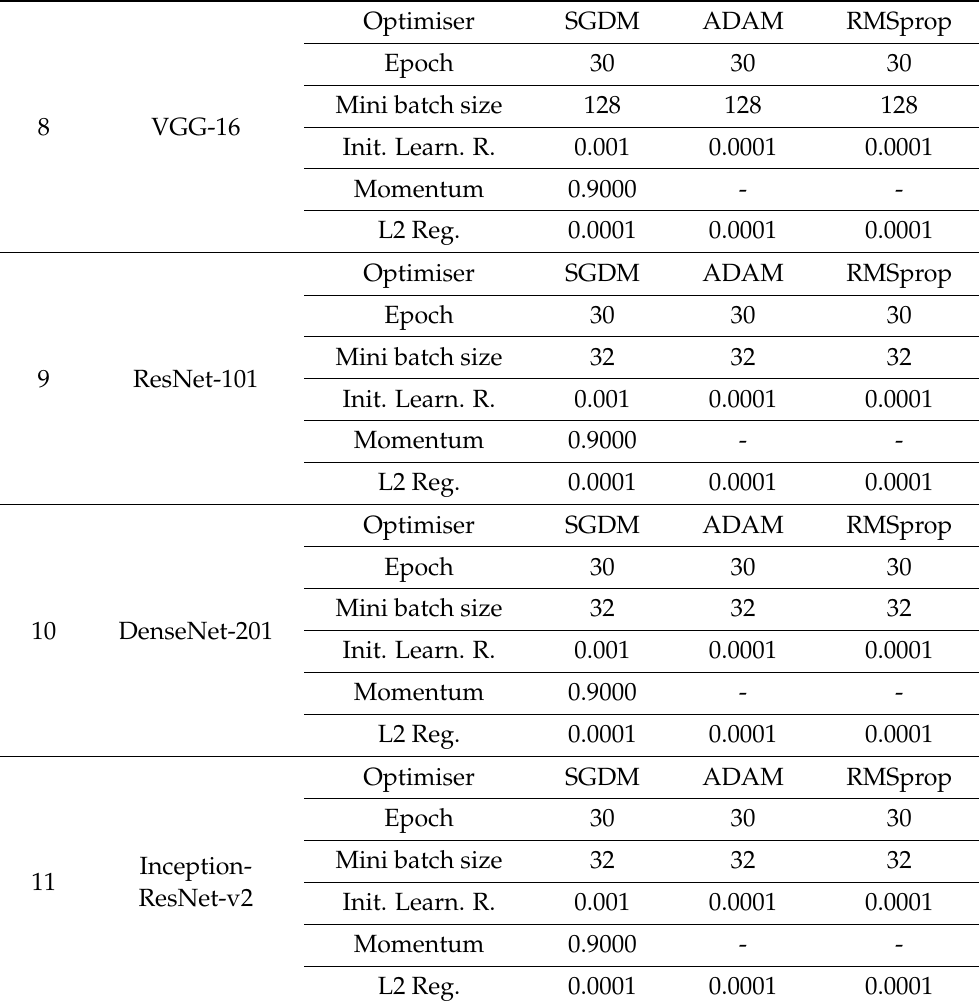
Table 5. Summary of convolutional neural networks (CNNs) hyper-parameters for this work (contin-